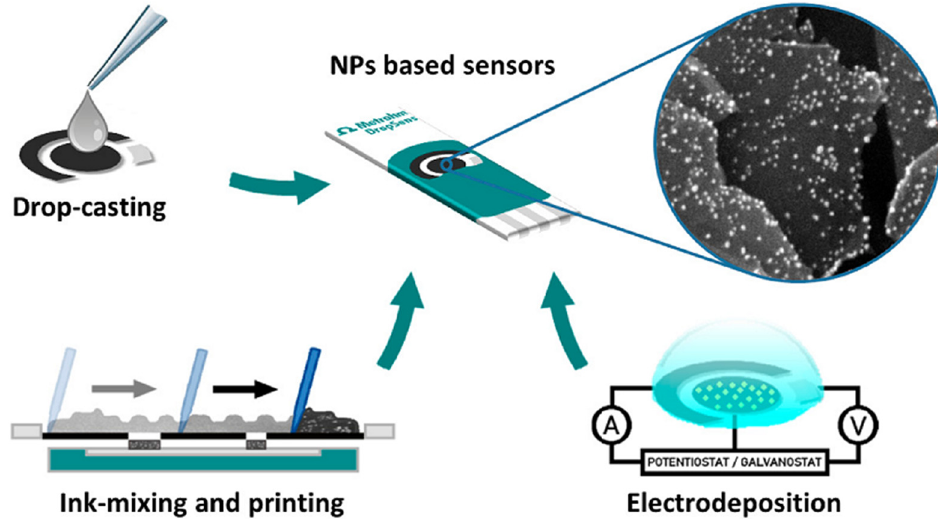
Figure 4. Schematic of the three main procedures for SPE modification using metal NPs (adapted and reprinted with permission from [45]).